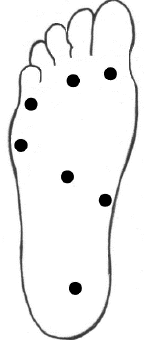
Figure 2. Plantar pressure pain reference points.